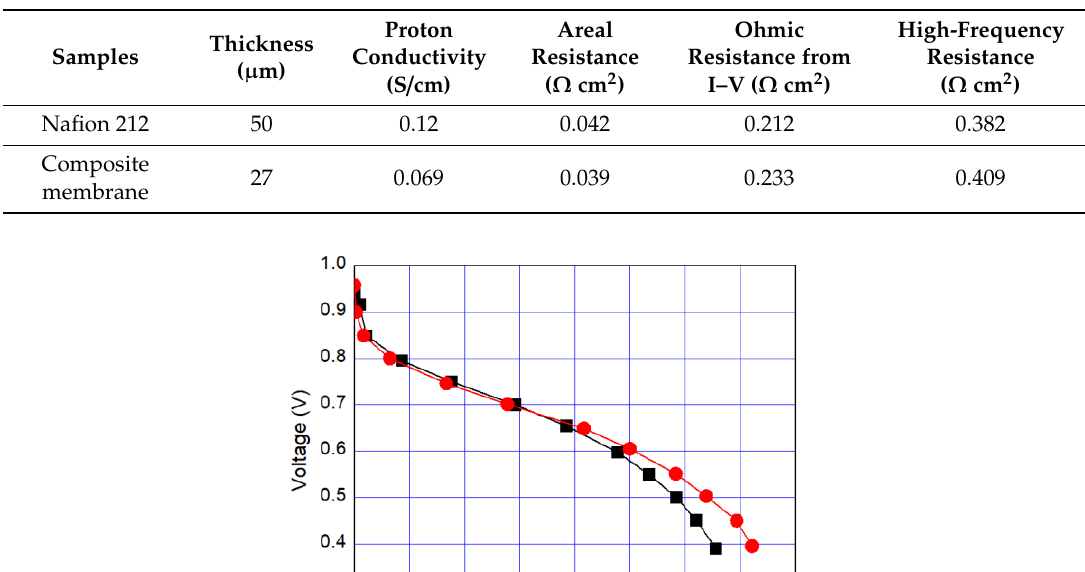
Table 7. Physical properties of Nafion 212 and the composite membrane using the GA/#3_30 and the summary of the I–V polarization curves of the membrane-electrode assemblies using Nafion 212 and the composite membrane.